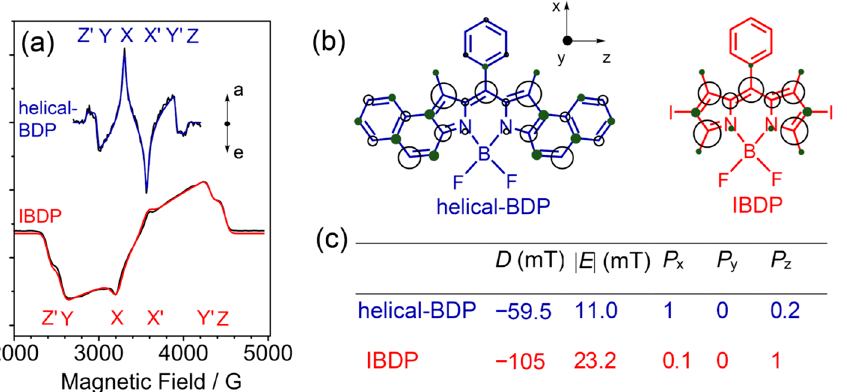
Figure 9. ( a ) TREPR spectra of helical-BDP ( λ ex = 555 nm) and IBDP ( λ ex = 532 nm) in toluene/MeTHF ( v / v , 3:1) frozen mixed solution (black line: experimental spectrum, blue and red lines: simulation results), c = 3.0 × 10 − 5 M, 80 K. ( b ) Spin density distribution of helical-BDP and IBDP. ( c ) Parameters used for the simulations of the spectra in ( a ). Reproduced with permission from reference [54], copyright 2020, Wiley-VCH.